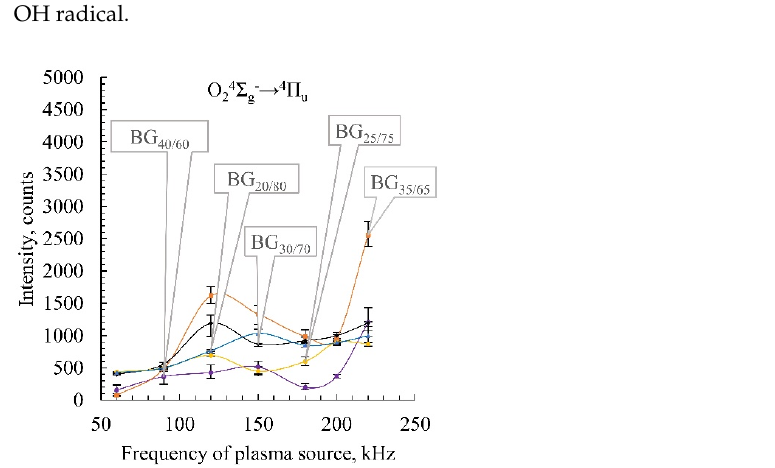
Figure 8. Graphs of intensity deviation according to frequency for O 2 radical.